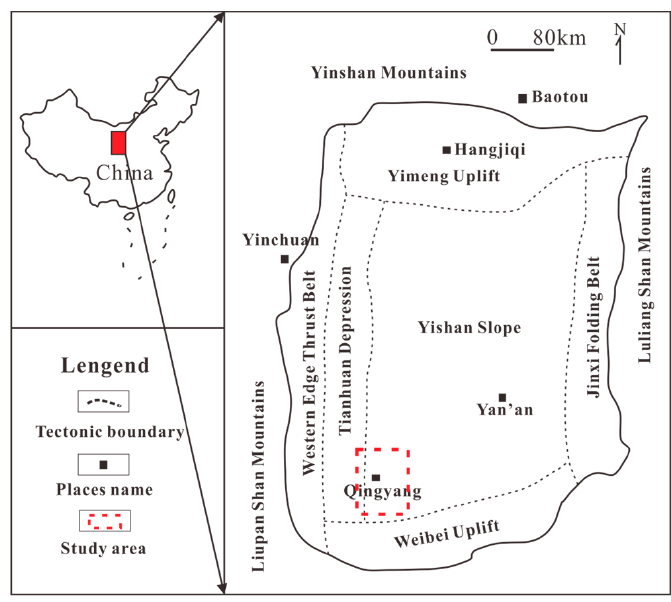
Figure 1. The location of research area.